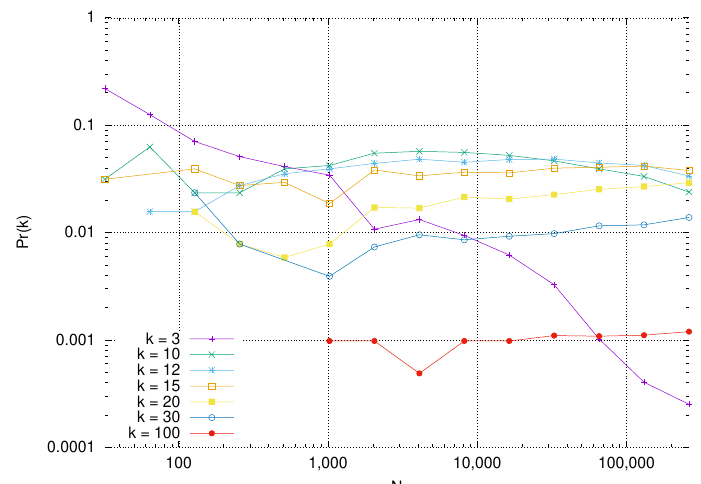
Figure 3. Plot of probabilities of node degrees having various values of k , against the network size N , for d = 2, τ = 1/30, 2 σ = 1, and ν = 1. Here, for the measured probabilities, we generate a single network for each N , and simply plot the number of nodes of degree k divided by N . Although we have not directly estimated the accuracy of these numbers, one can nevertheless see how Pr ( k ) → 0 for fixed k as N → ∞